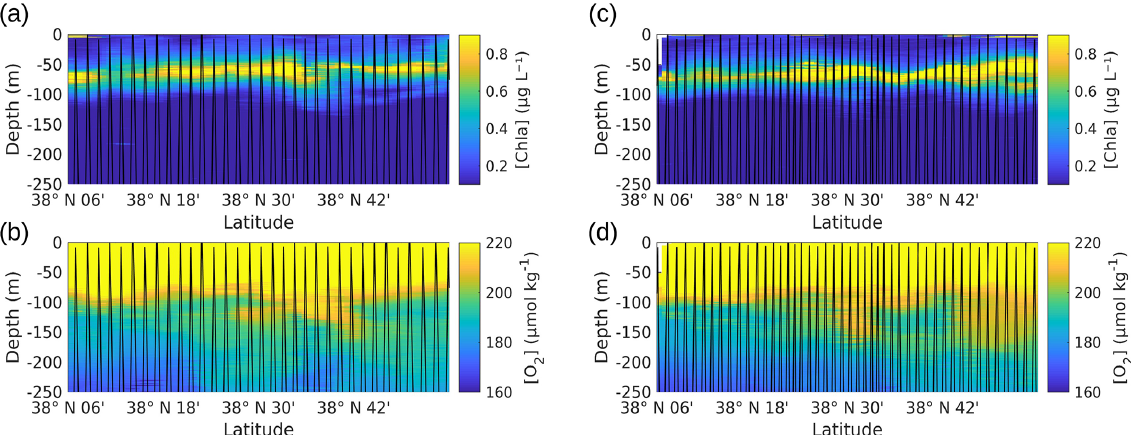
Figure A4. Vertical profiles of [chl a ] (a, c) and dissolved oxygen concentration (b, d) , measured by the SeaExplorer glider, along the outward route (a, b) from 6 May 2018 at 00:00 to 9 May 2018 at 21:00UTC and along the return route (c, d) from 10 May 2018 at 00:00 to 13 May 2018 at 21:00UTC. The SeaExplorer glider trajectory is depicted by the black lines. The data were selected between the surface and 250m for a better visualization of the surface layer.